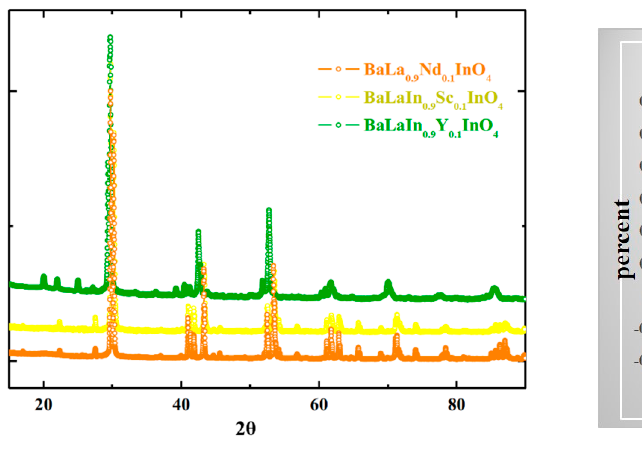
Figure 2. The XRD-patterns of isovalent-doped compositions BaLa 0.9 Nd 0.1 InO 4 , BaLaIn 0.9 Sc 0.1 O 4 , BaLaIn 0.9 Y 0.1 O 4 ( a ) and lattice parameters changes of these compositions compared with BaLaInO 4 ( b ).